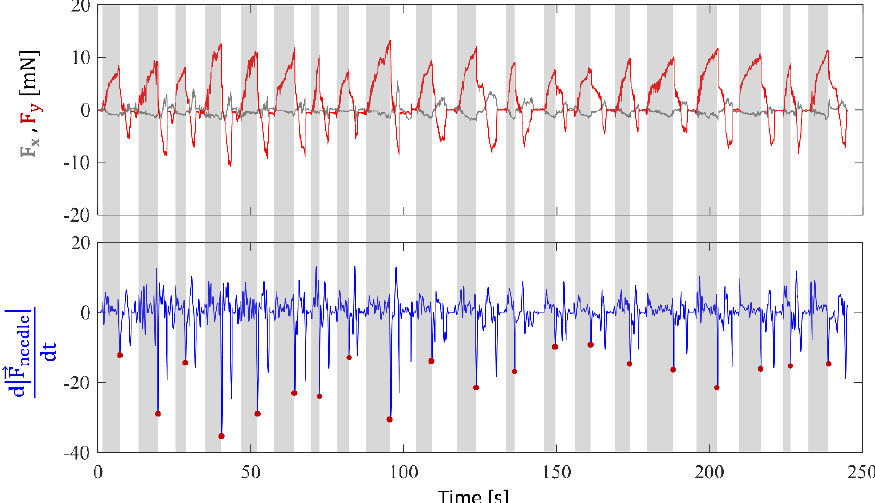
Figure 9. Measured forces during 20 consecutive punctures on the stretched vinyl membrane phantom. Grey zones correspond to the needle insertion phase while the white regions are for the retraction of the needle after puncture. During the insertion phase, most of the forces are along the needle axis (y-axis of the tool), with minor side load (F x < 5 mN). The peak force before puncture ranges from 7.72 mN to 13.48 mN as the stretch of the phantom was adjusted targeting a range of 8–15 mN. The rate of force drop at the instant of piercing the membrane (marked with red dots in the lower plot) vary with a minimum of −35.21 mN/s and maximum of −8.73 mN/s for this set of trials. Table 2. Puncture detection rates with the force-based versus the force-and-position-based methods for two users with differing skill and experience (n = 24 trials per user).